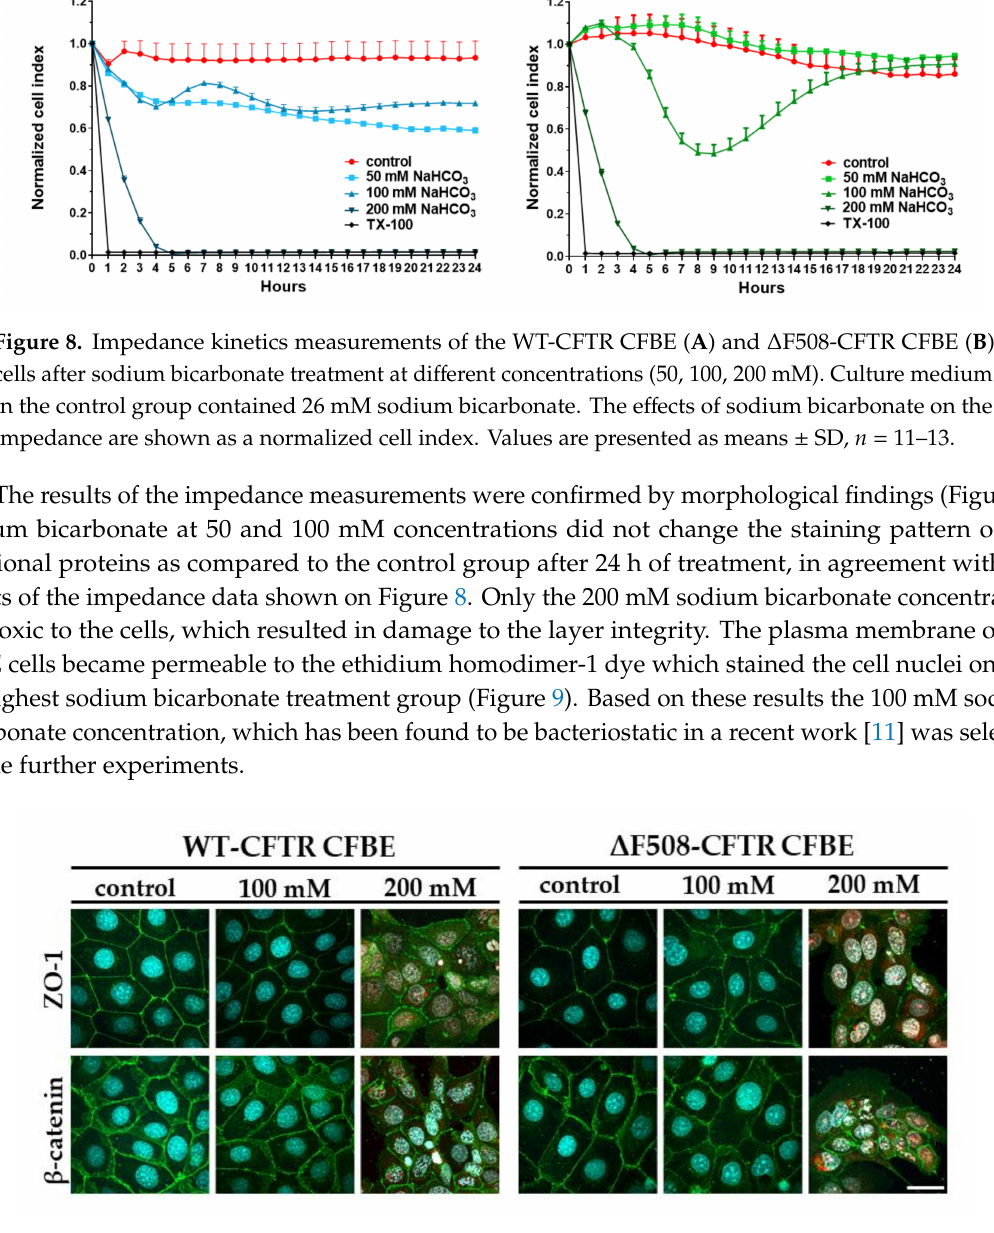
Figure 9. Morphology of CFBE cells after sodium bicarbonate treatment at di ff erent concentrations. Cells were treated with culture medium containing 26 (control group), 100 and 200 mM sodium bicarbonate for 24 h. Green color: immunostaining for junctional proteins. Cyan color: cell nuclei. Red color: nuclei of damaged cells. Bar: 40 µ